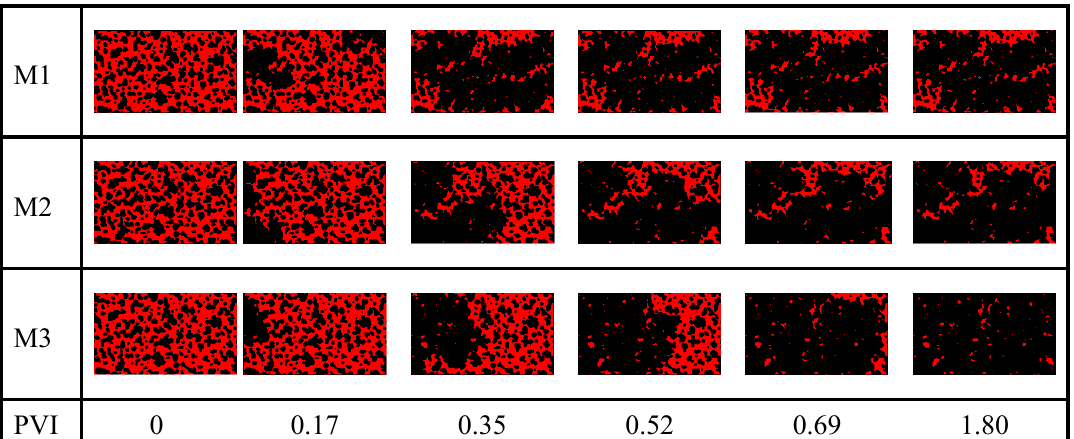
Figure 9. Results for the low rate injection microfluidic experiments: ( a ) oil recovery factor; ( b ) normalized Euler number; ( c ) number of clusters versus pore volume injected; and ( d ) normalized cumulative residual oil volume, as a function of oil cluster size.